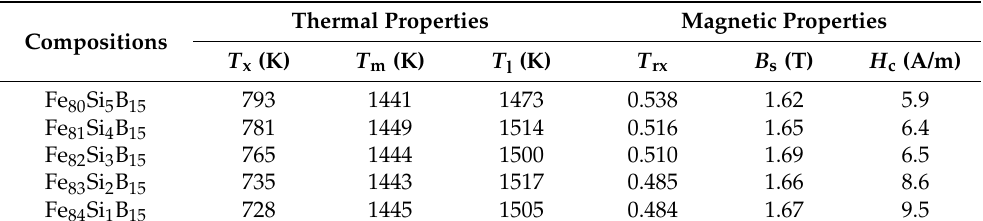
Figure 6. DSC curves of the Fe 80+x Si 5 − x B 15 (x = 0–4) amorphous ribbons. Table 6. Thermal properties ( T x , T m , and T l ) and magnetic properties ( B s and H c ) of the Fe 80+x Si 5 − x B 15 ( x = 0–4) amorphous alloys.